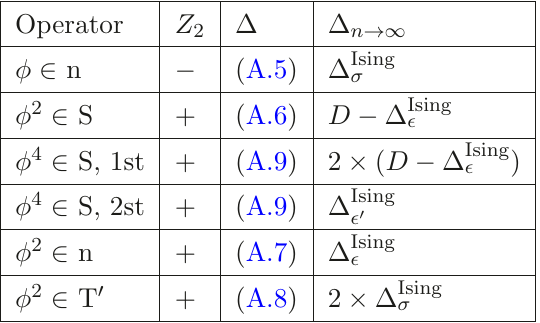
Table 1 . Scaling dimensions of low-lying operators at the fixed point P 1 .